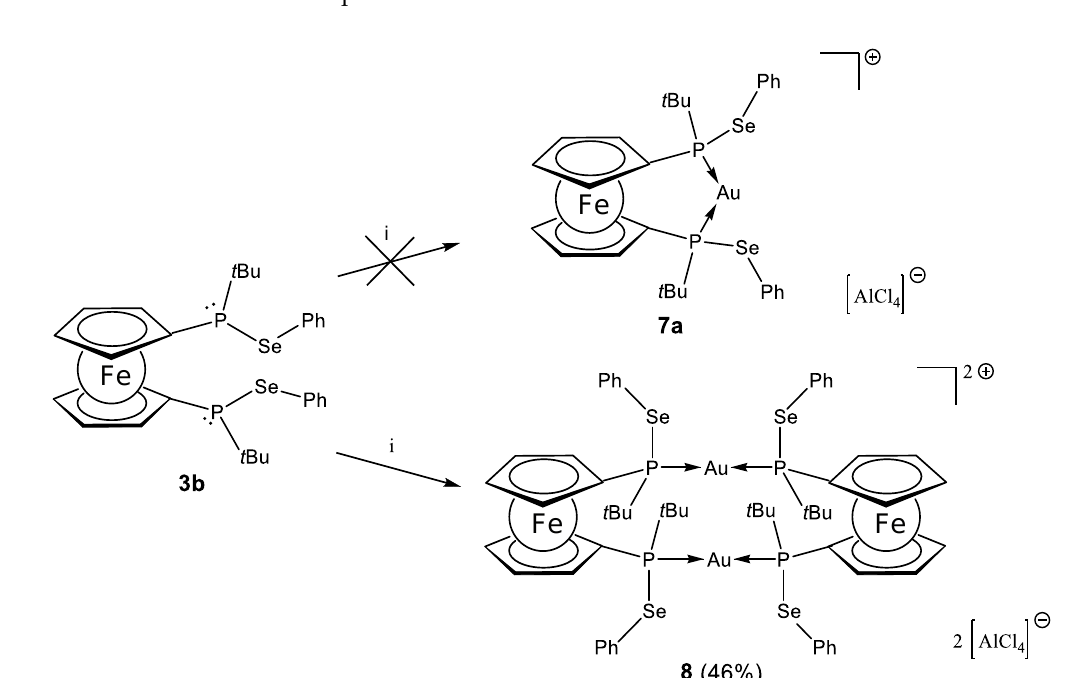
Scheme 4. Synthesis of an ionic gold(I) metal complex with 3b as ligand. i: 1 equiv. (tht)AuCl and AlCl 3 , rt, 30 min.